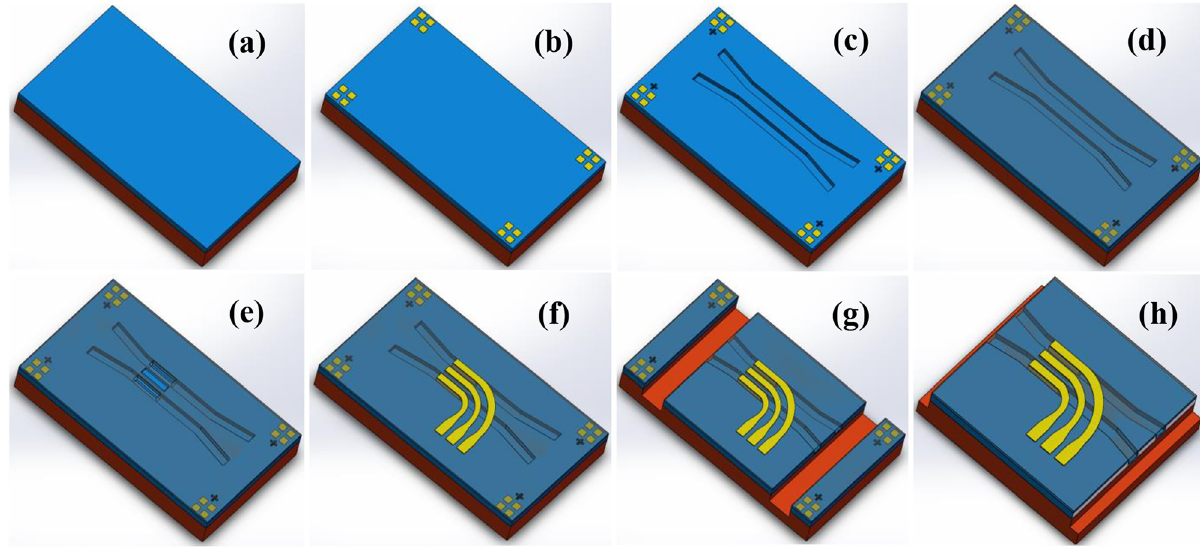
Figure 4: The schematic diagram of the fabrication process. (a) Chip washing, (b) metal marks fabrication, (c) waveguide patterning and etching, (d) deposition of passivation layer, (e) contact windows patterning and etching, (f) metal contact patterning and evaporation, (g) lithography and deep etching and (h) chip